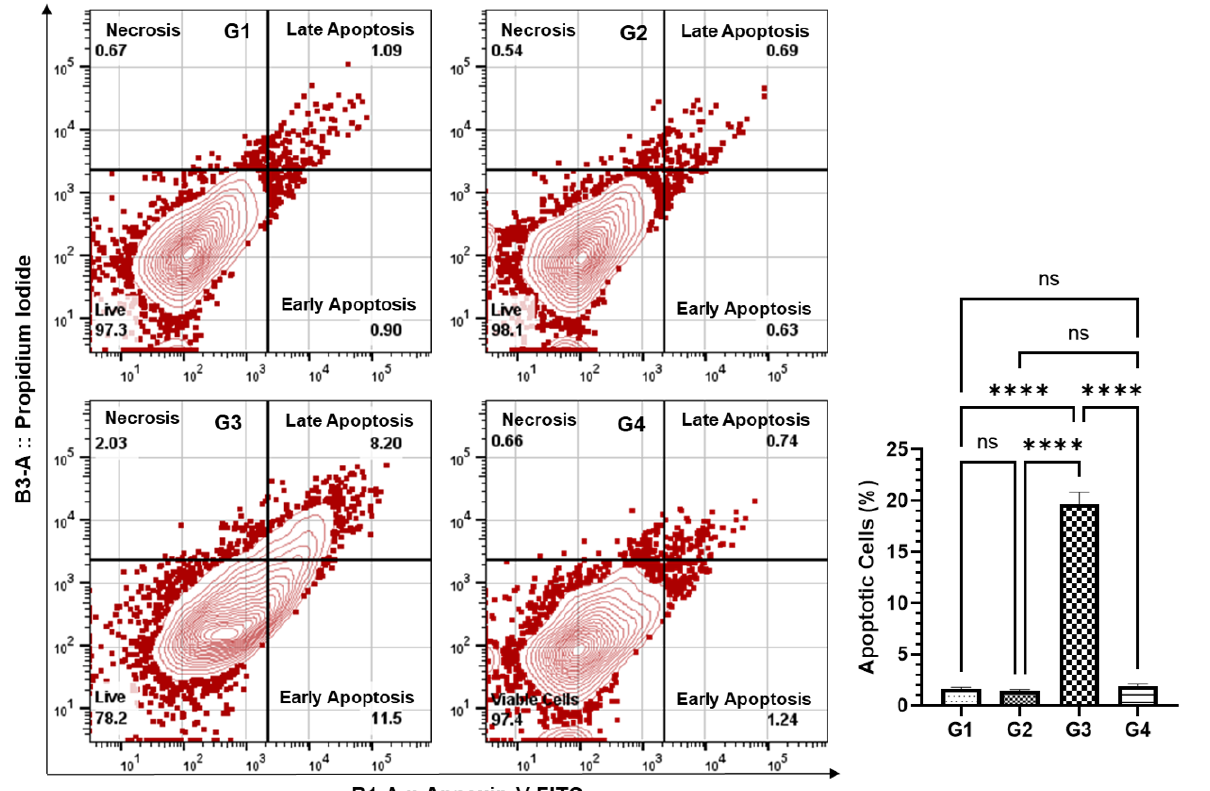
Figure 8. Effect of AAE on the induction of apoptosis in the lung cells by Annexin V-FITC-PI using flow cytometry. The values are given as the SEM of three different experiments. ns No significance within the groups; **** significant difference between the groups, p -value < 0.0001.